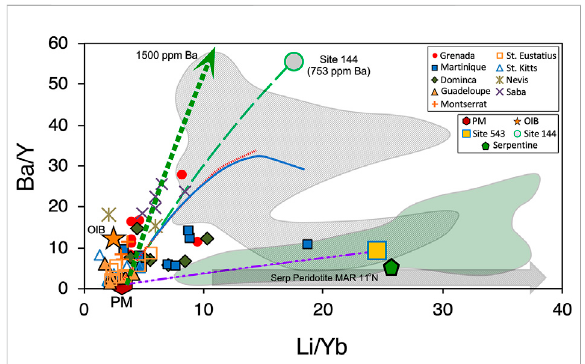
FIGURE 13 Variation of LAIA whole rock samples versus the fi elds of compositionsforSite543and144.Site543hashighLiwithrespect to Ba while 144 extends to higher Ba. Note that average serpentines from Savov et al. (2005) plot close to site 543 on this diagram. Mixing endmember compositions of average Site 543 and 144 can reconcile many LAIA compositions but require both northern magmas and Grenada magmas to be mixed with a sediment component similar to each other and Site 144. Red and blue lines are AFC models and green mixing curves are as described in Figure 13 and require a high Ba component. Purple dot-dashed line is binary mixing between PM and Site